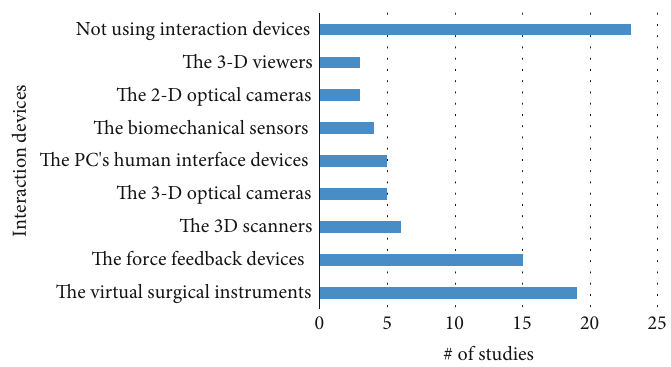
Figure 6: The distribution of using interaction devices in the chosen